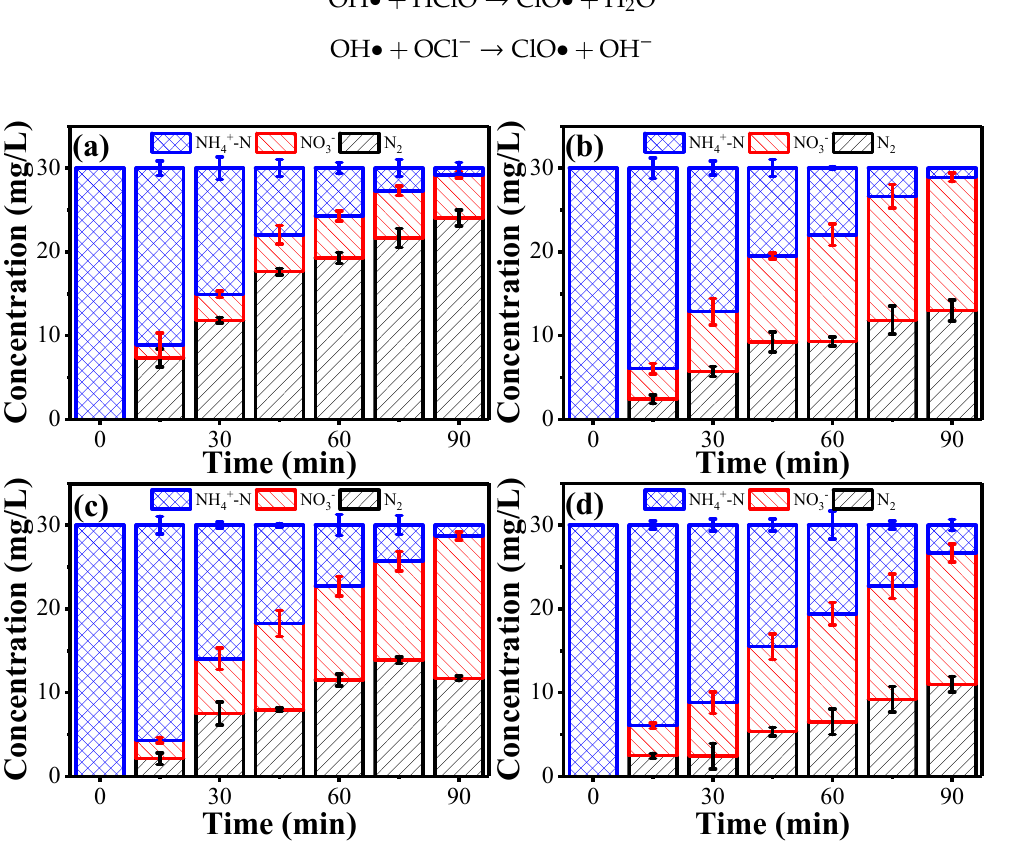
Figure 3. The conversion of ammonia in 90 min by employing di ff erent cathode materials: ( a ) Pd-Cu / NF, ( b ) Pd / NF, ( c ) Cu / NF, and ( d ) NF. Reaction conditions: anode potential of 2.8 V vs. Ag / AgCl, [Cl − ] of 0.14 M, flow rate of 1.5 mL · min − 1 , and pH 9.